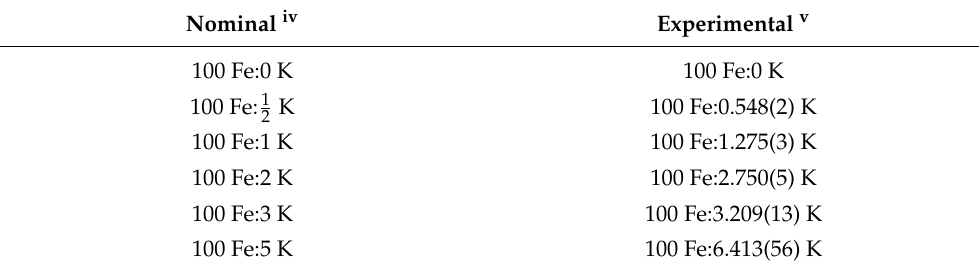
Table 2. Bulk compositional analysis of the materials.